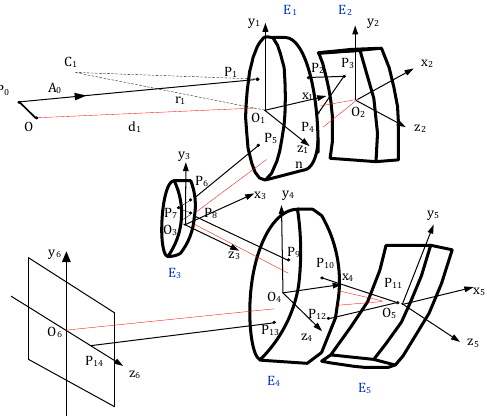
Figure 2. Dispersion diagram of a curved prism-based spectrometer.